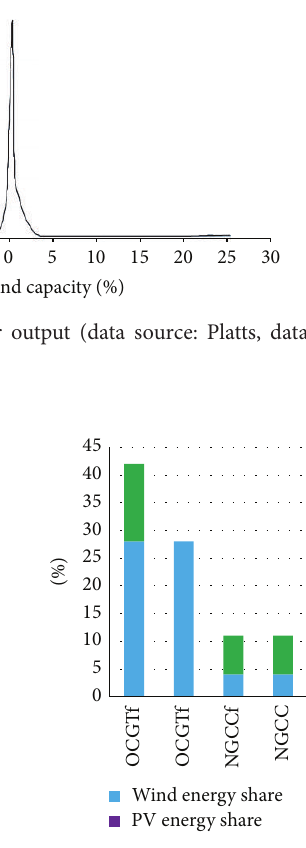
Figure 4: Energy mix of the renewable energy share in the “optimal